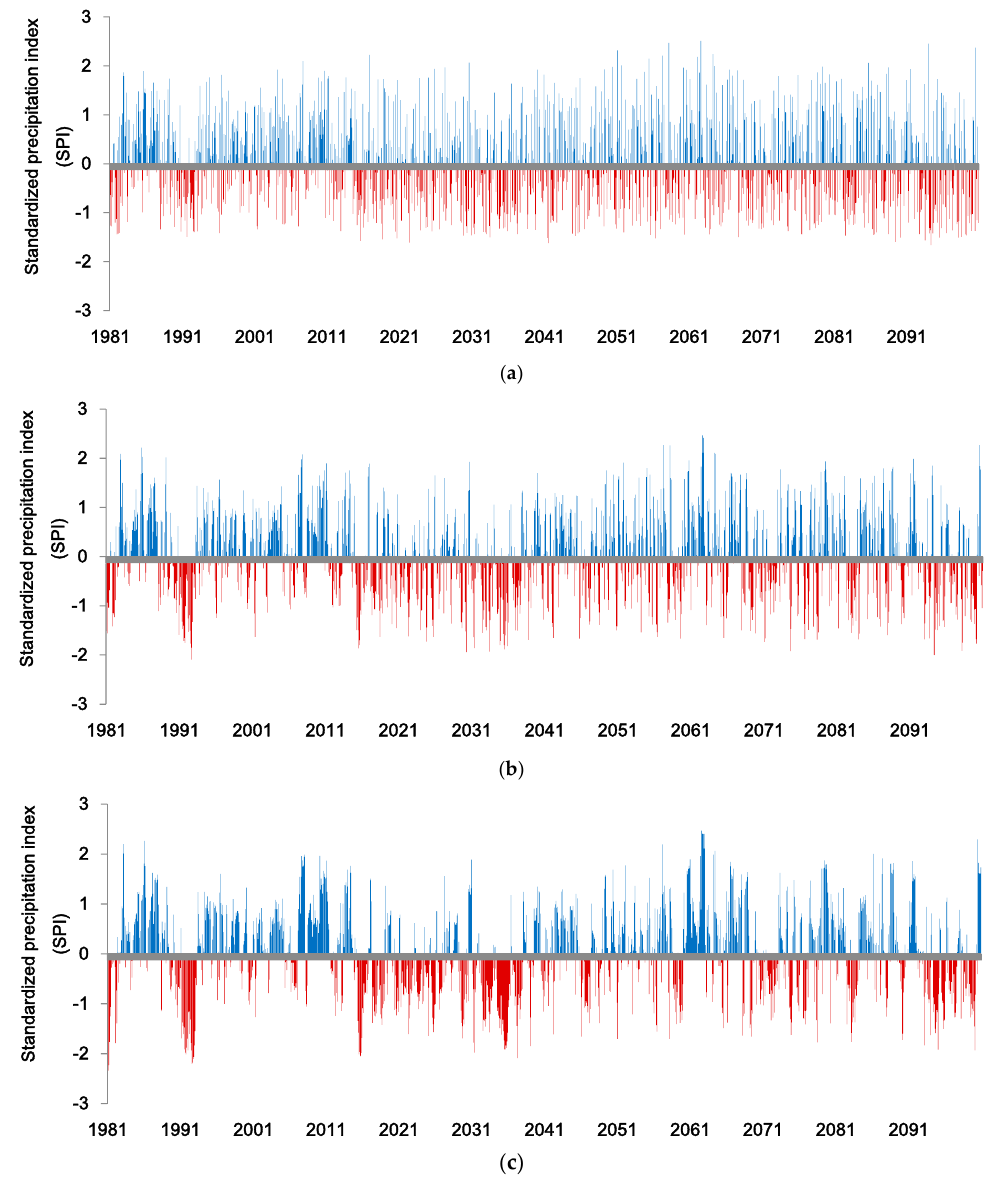
Figure 4. SPI on different timescales (one, three, and six-month) from 1981 to 2100: ( a ) one-month SPI; ( b ) three-month SPI; ( c ) six-month SPI.